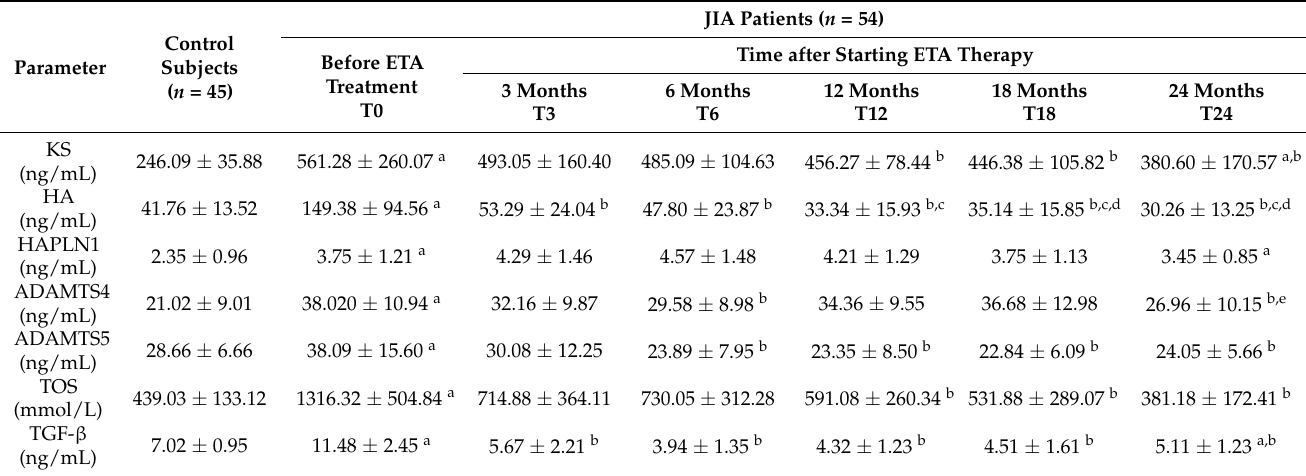
Table 2. The distribution patterns of plasma KS, HA, HAPLN1, ADAMTS4, ADAMTS5, TOS and TGF- β in the healthy individuals (control subjects) and JIA